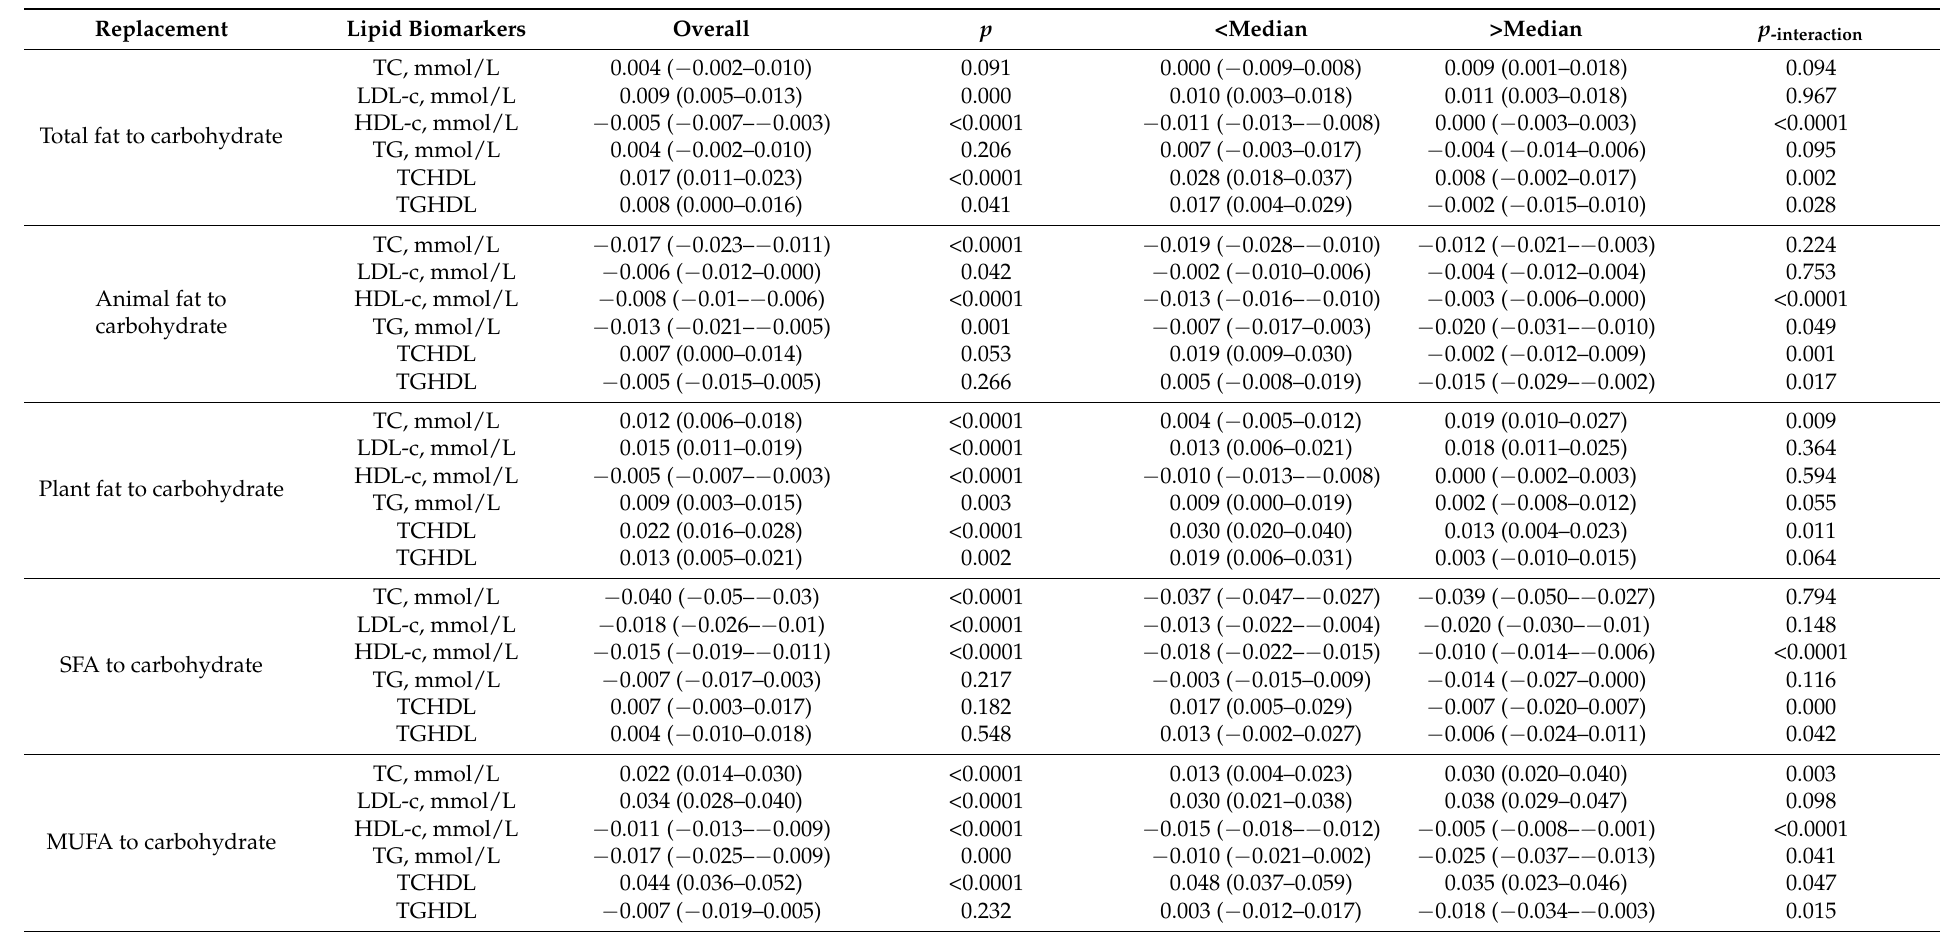
Table 4. Changes in lipid biomarkers when dietary fats were replaced by carbohydrate, stratified by fat intake level